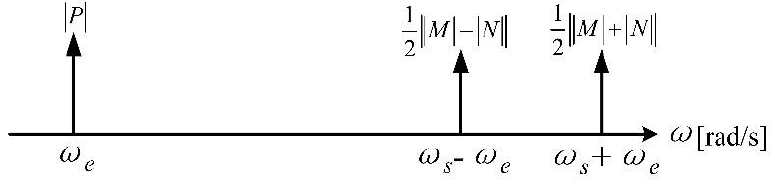
Figure 5. Spectrum of the microsensor output signal under the power frequency field.